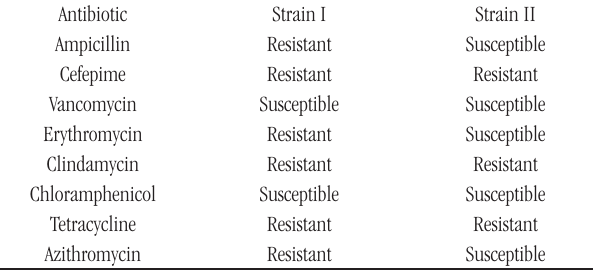
table 2 – Antimicrobial susceptibility profile of GBS isolates Antibiotic Strain I